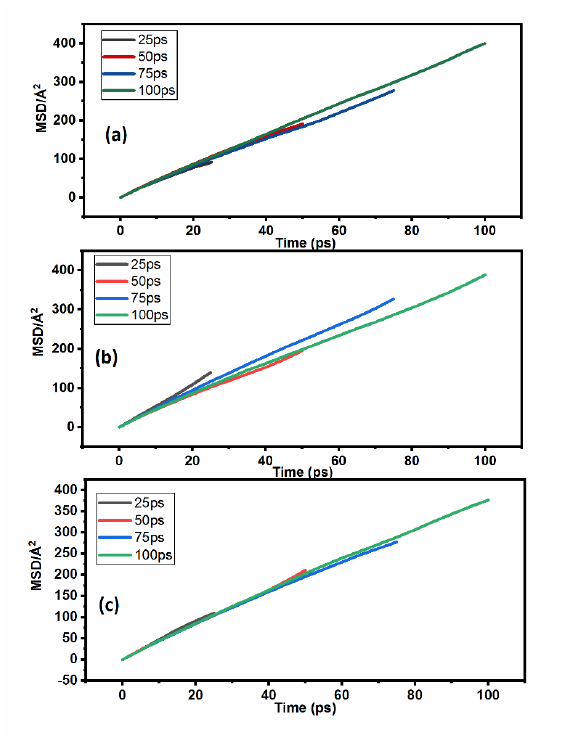
Figure 7. Time effect on diffusivity of SVOCs: a) CAP, b) MIC, c) NAPH in